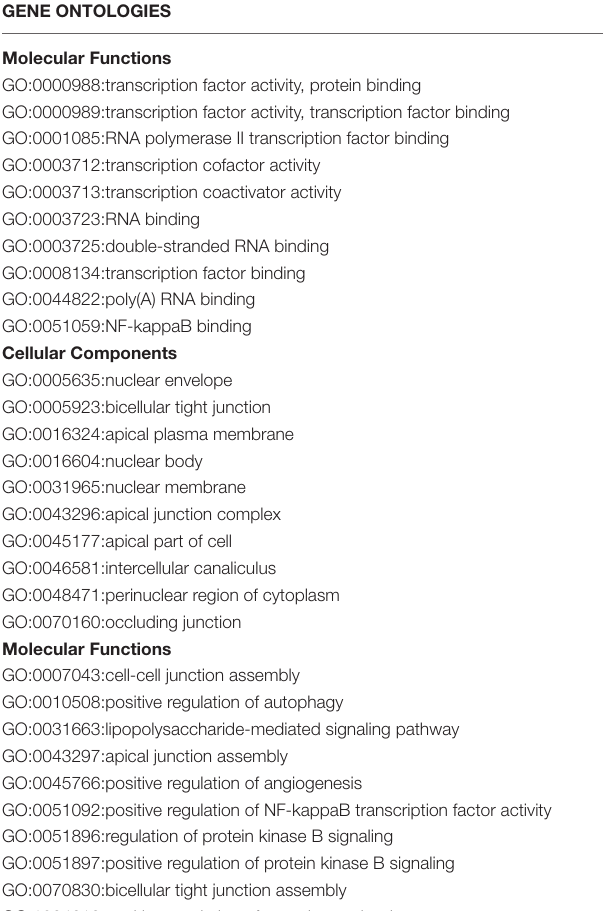
TABLE 1 | MTDH containing gene ontologies.